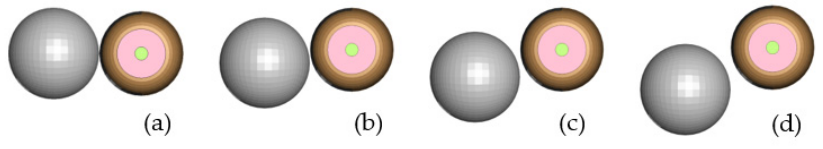
Figure 8. Off-center impacts ( a ) 0/3R, ( b ) 1/3R, ( c ) 2/3R, ( d ) 3/3R, where R is the radius of the